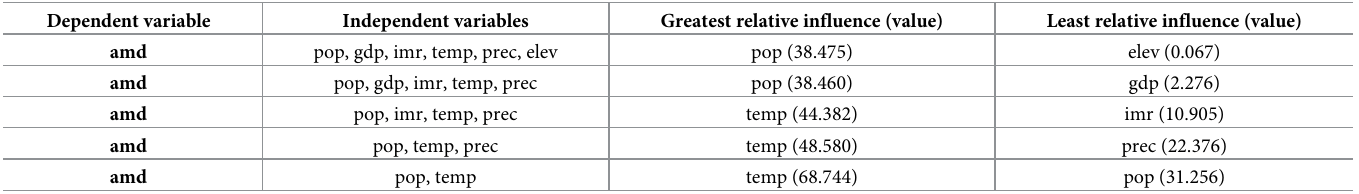
Table 2. Gradient Boosting Machine (GBM) to determine best-fit model. Abbreviated variable names include human population density (pop), gross domestic product (gdp), infant mortality rate (imr), annual mean temperature (temp), annual cumulative precipitation (prec), elevation (elev). Dependent variable